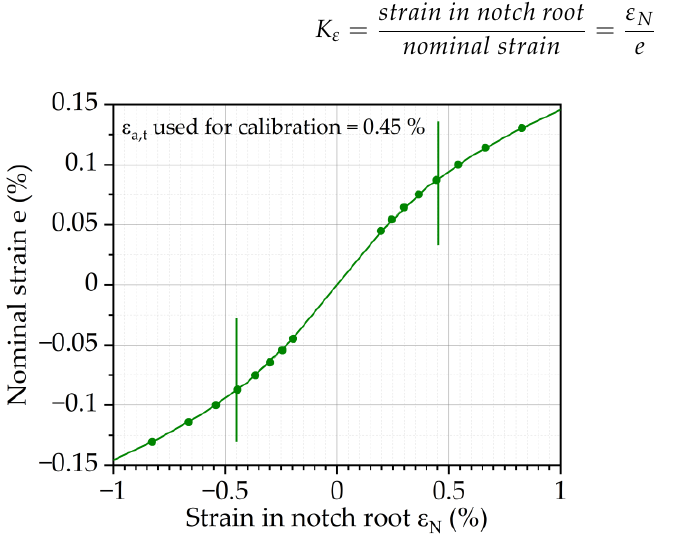
Figure 12. Comparison of simulated load increase test of a specimen with R N = 0.35 mm using Chaboche parameter set for tests conducted at RT, with measured data of a nominal LIT (Specimen 14.7) and a nominal SIT (Specimen 14.3).